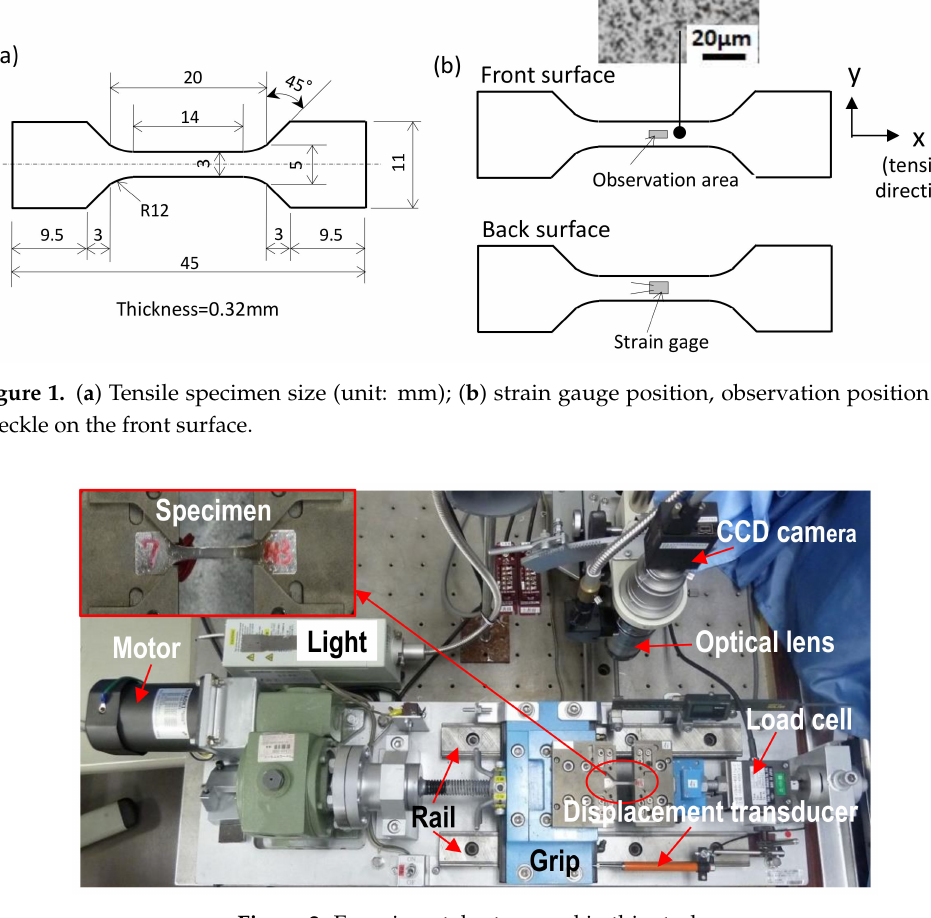
Figure 2. Experimental setup used in this